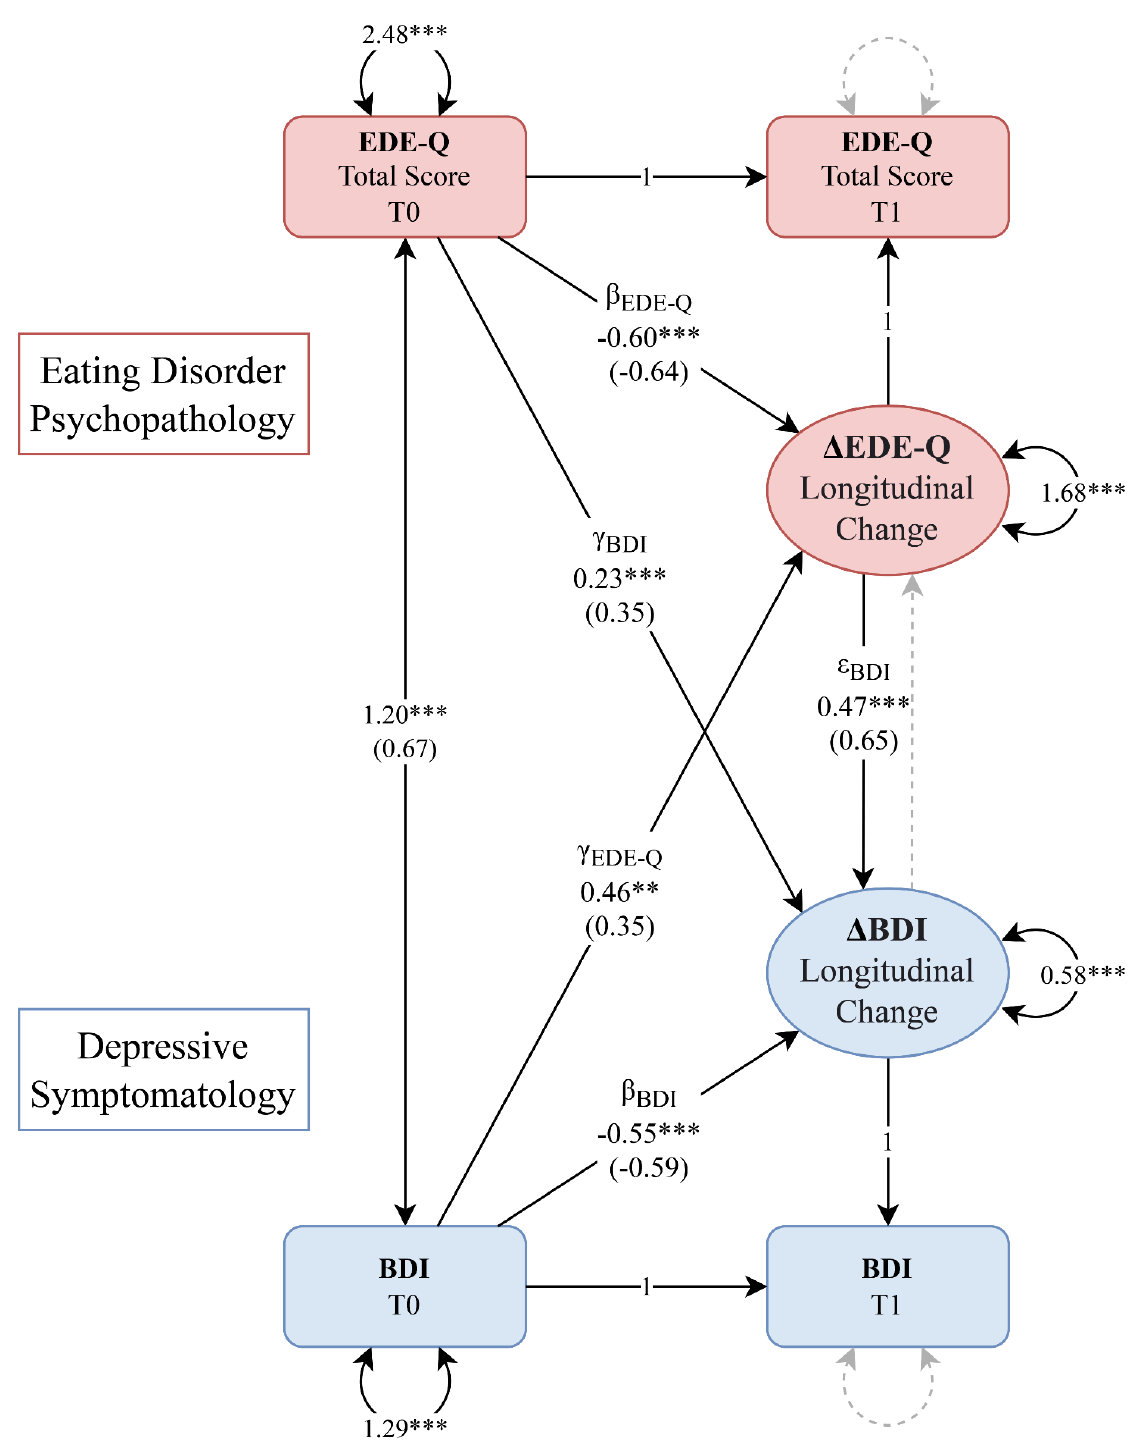
Figure 1. Bivariate latent change score (LCS) model of the associations between eating disorder psychopathology (in red) and depressive symptoms (in blue). Rectangles represent observed variables, and circles represent latent variables (LCSs). Regression effects and loadings are illustrated as single-headed arrows, labeled with their unstandardized and standardized (in parenthesis) coefficients. Effects or variances constrained to zero are illustrated as grey arrows, whereas those constrained to one are labeled as ‘1’. Double-headed arrows represent variances and covariances. ** p < 0.01, *** p < 0.001 BDI, Beck Depression Inventory; EDE-Q, Eating Disorder Examination Questionnaire.